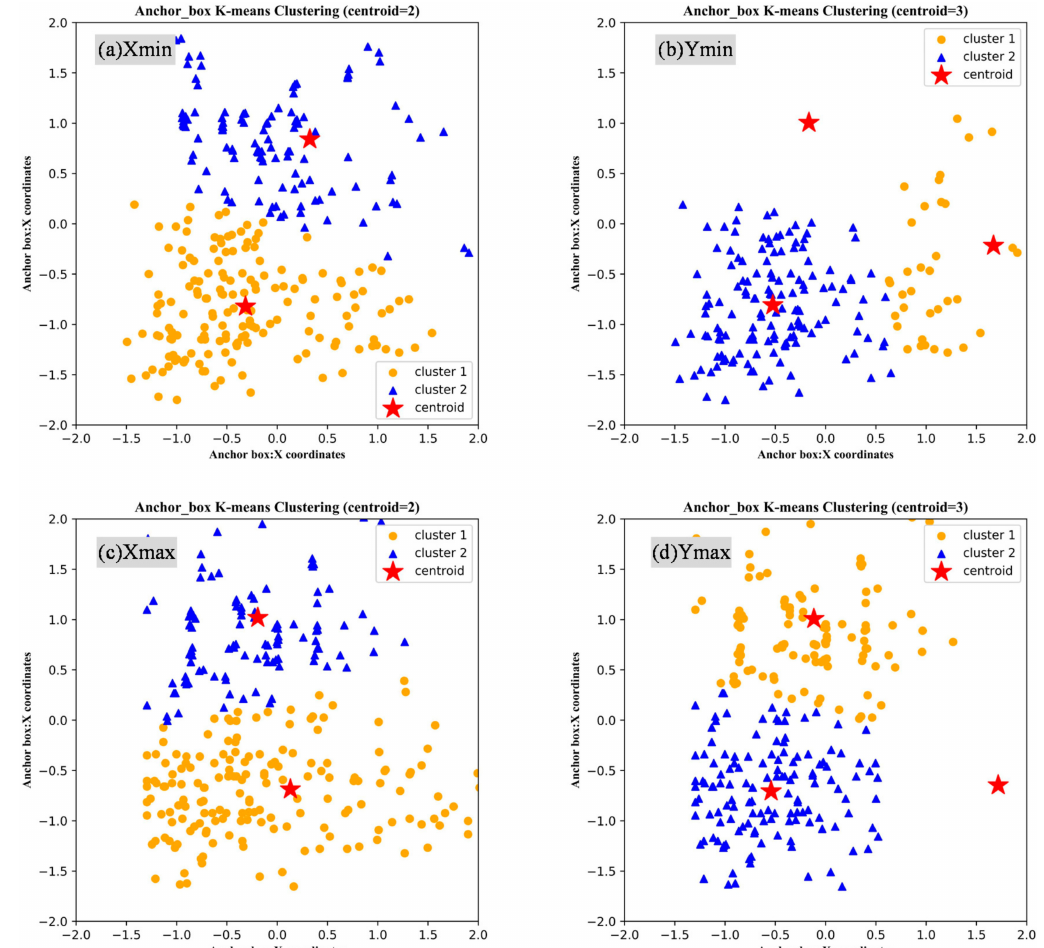
Figure 8. K-means clustering analysis of anchor boxes: ( a , b ) are related to Xmin and Ymin coordinates; ( c , d ) are related to Xmax and Ymax